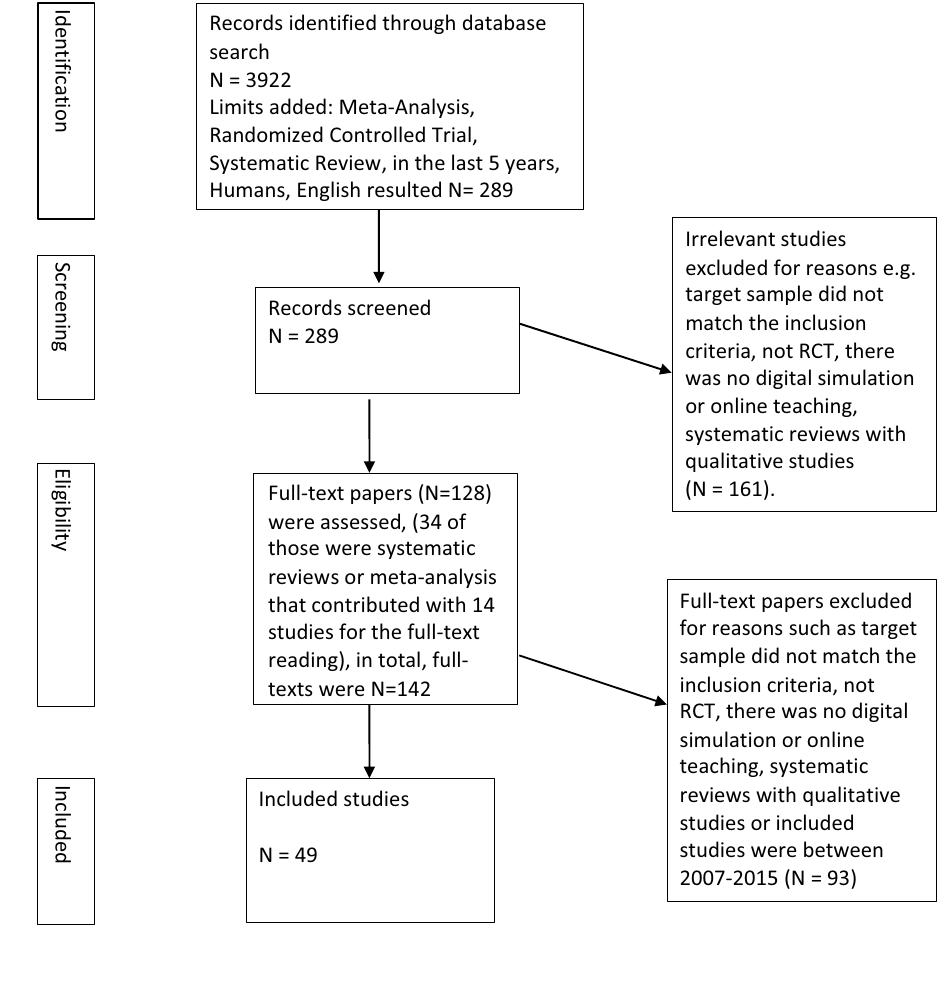
Fig. 1 PRISMA chart for the study selection